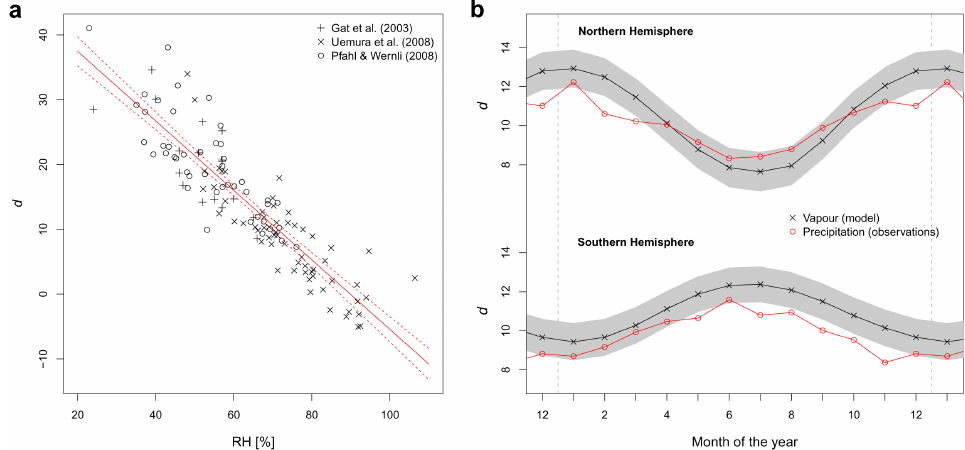
Fig. 1. Deuterium excess d of water vapour and precipitation. (a) Scatter plot of water vapour d from several published data sets (Gat et al., 2003; Uemura et al., 2008; Pfahl and Wernli, 2008) against RH at the oceanic moisture source. The solid red line indicates a linear regression, which is used for the calculation of moisture source d in our statistical model, the dashed lines show the uncertainty of this regression based on a 95% confidence interval. (b) Seasonal cycle of d in ocean evaporation (black crosses and gray shading), as obtained from the linear regression model based on reanalysis RH, averaged over the Northern and Southern hemispheres. Red circles show hemispherically averaged d of precipitation from GNIP